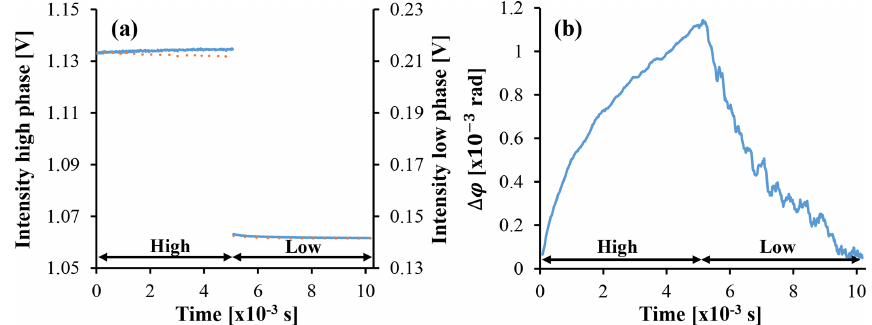
Figure 4. (a) Typical raw signals from the interferometer outputs ( I 1 , I 2 ; blue and red dotted lines, respectively) measured during a modula- tion cycle with a strongly absorbing sample. Over the course of the heating (high) phase, an intensity difference arises between the outputs. (b) This effect is seen more clearly in the resultant phase shift, which is calculated by normalising the difference of the raw signals by the total intensity (Eq. 5). The baseline offset has been